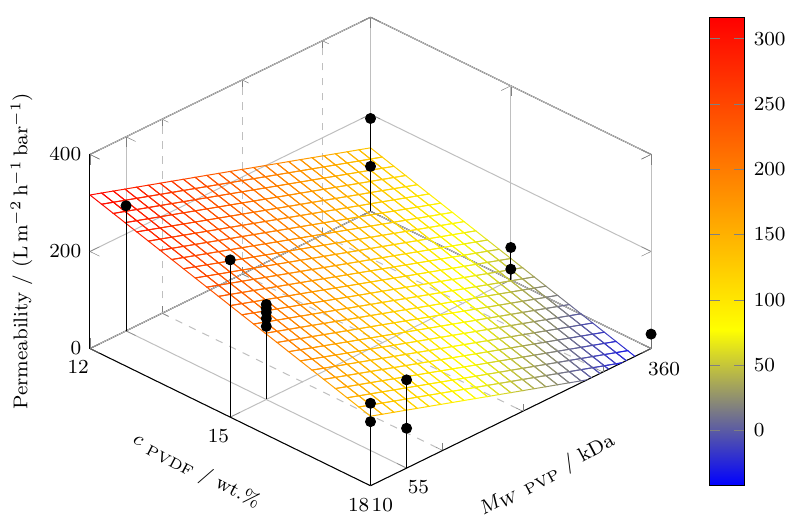
Figure 1. Regression hyperplane showing the linear fit of permeability to PVDF concentration and PVP molecular weight at T Dope = 35 ◦ C, T H = 35 ◦ C, c PVP = 5%, M W PVDF = 585 kDa. Black dots 2 O represent experimental values of entire design space ( n = 16).